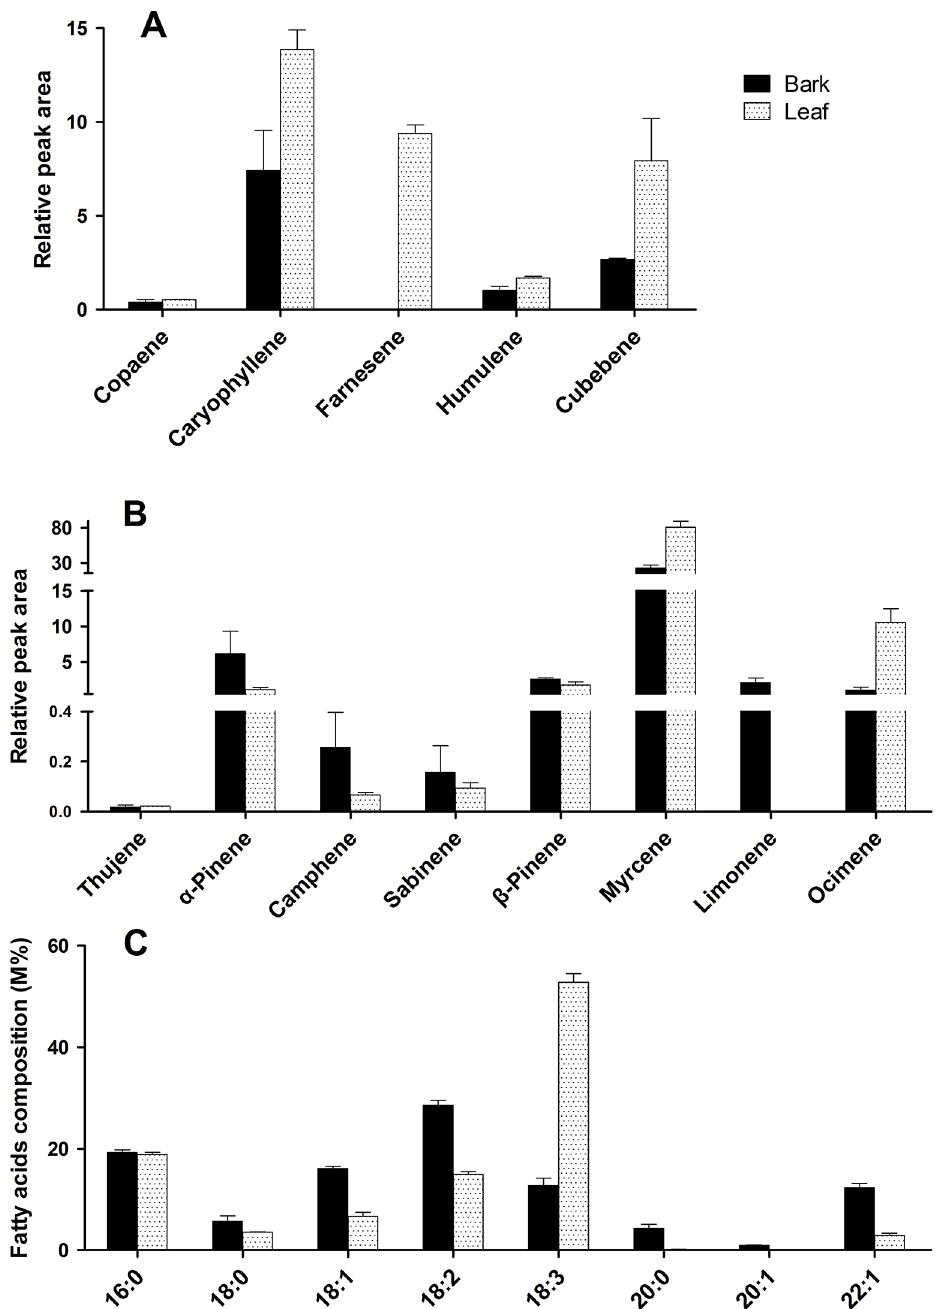
Fig 1. The phytochemical analysis of terpenoid and fatty acid compositions in W . ugandensis bark and leaf. The relative content of monoterpenes (A), sesquiterpenes (B), and fatty acid compositions (C) were